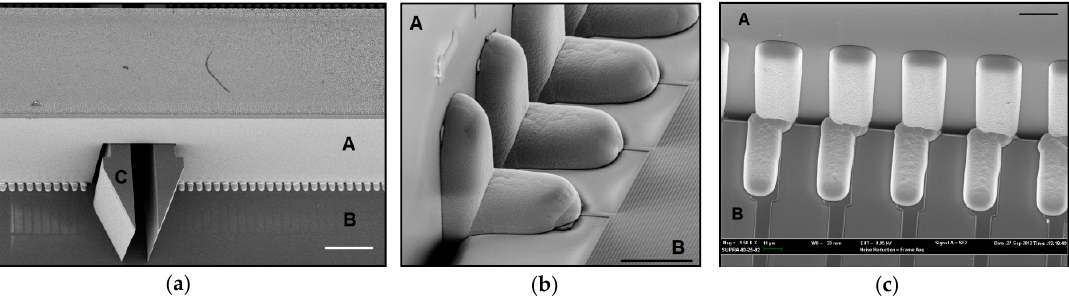
Figure 10. ( a ) SEM image of the 40 µm pitch connections of a 4480 recording site probe (design 3b